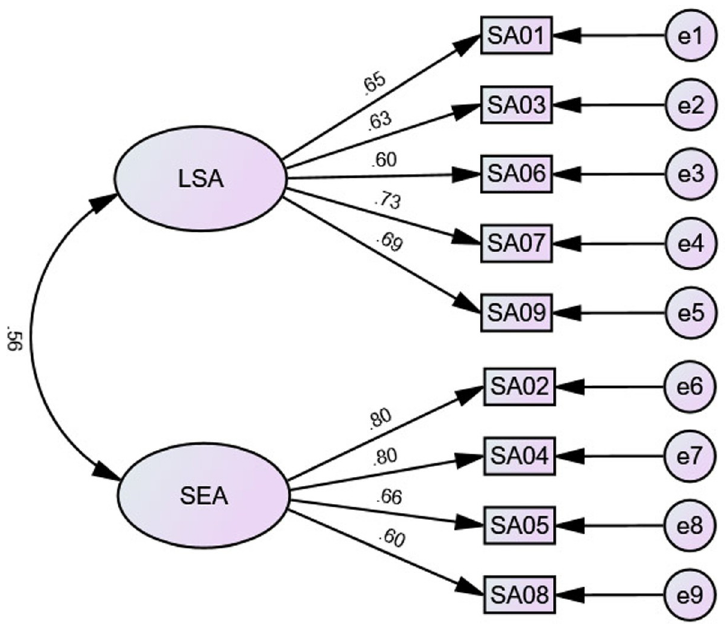
Fig 5. The factor structure of the ASAS in Study 2. LSA = learning science anxiety; SEA = science evaluation